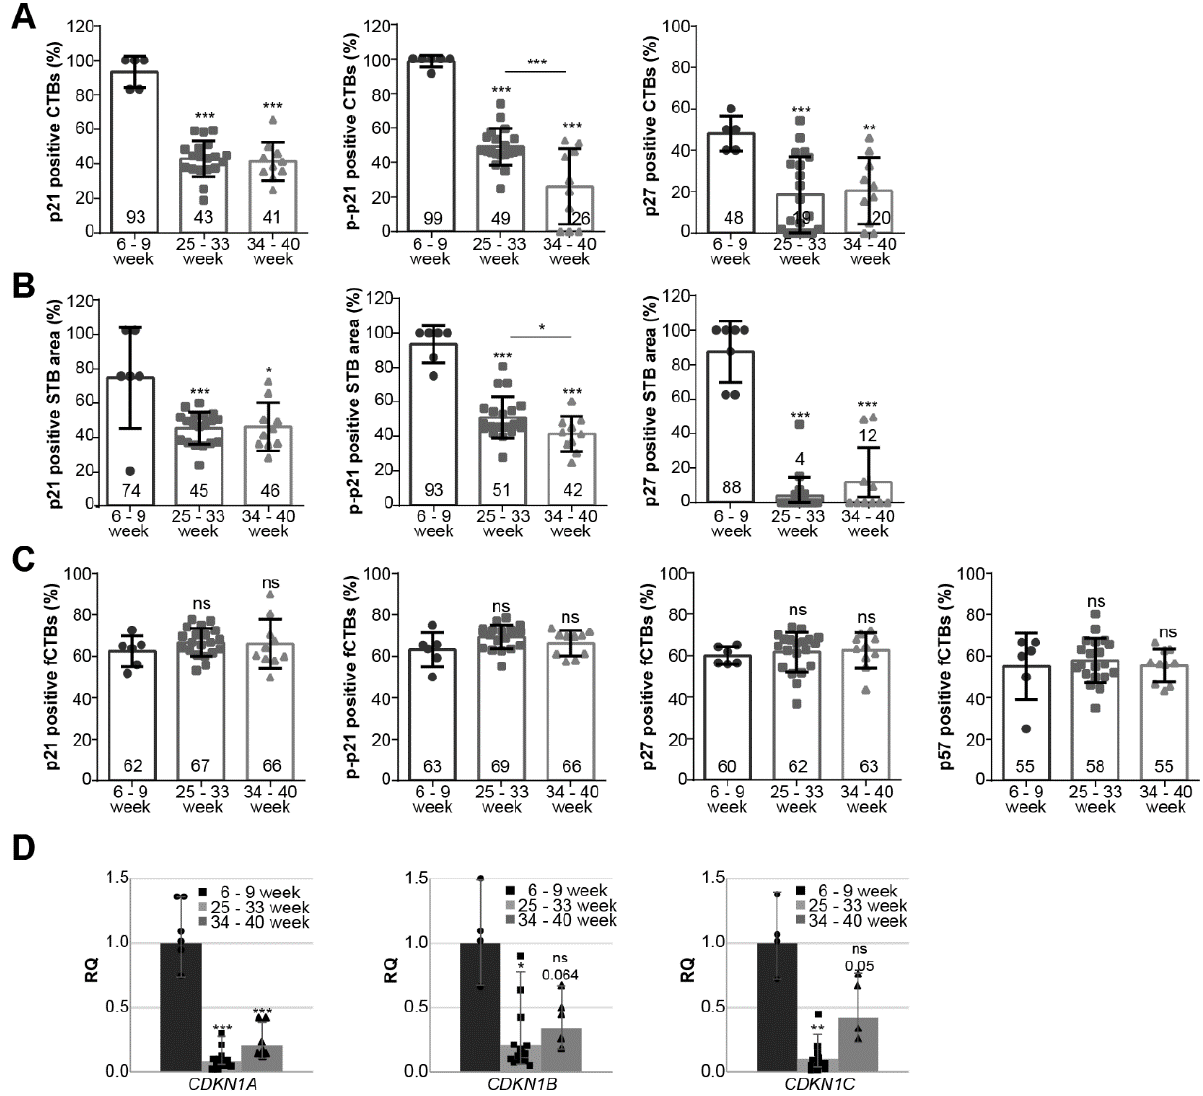
Figure 2. Cell cycle regulators are highly expressed during the first trimester of gestation. ( A – C ) Evaluation of positive cells in first trimester placental sections ( n = 6; named 6–9 week), early-onset control ( n = 20; named 25–33 week), and late-onset control samples ( n = 10; named 34–40 week). The results are presented as bar and scatter plots showing the mean value ± SD. ( A ) Quantification of p21 (left panel), p–p21 (middle panel), and p27 (right panel) positive CTBs in %. ( B ) Quantification of p21 (left panel), p-p21 (middle panel), and p27 (right panel) positive stained STB area in %. ( C ) Quantification of p21 (left panel), p–p21 (second panel), p27 (third panel), and p57 (right panel) positive fCTBs in %. ( D ) The relative amount of the gene levels was analyzed from placental tissues: left panel CDKN1A (p21), middle panel CDKN1B (p27), and right panel CDKN1C (p57). The results are presented as relative quantification (RQ) with minimum and maximum range. TBP was used as the endogenous control. Unpaired Student’s t -test or Mann–Whitney U test referring to first trimester samples was used for statistical analysis, * p < 0.05, ** p < 0.01, *** p < 0.001. CTBs, cytotrophoblasts; fCTBs, cytotrophoblasts ongoing to fuse; STB,